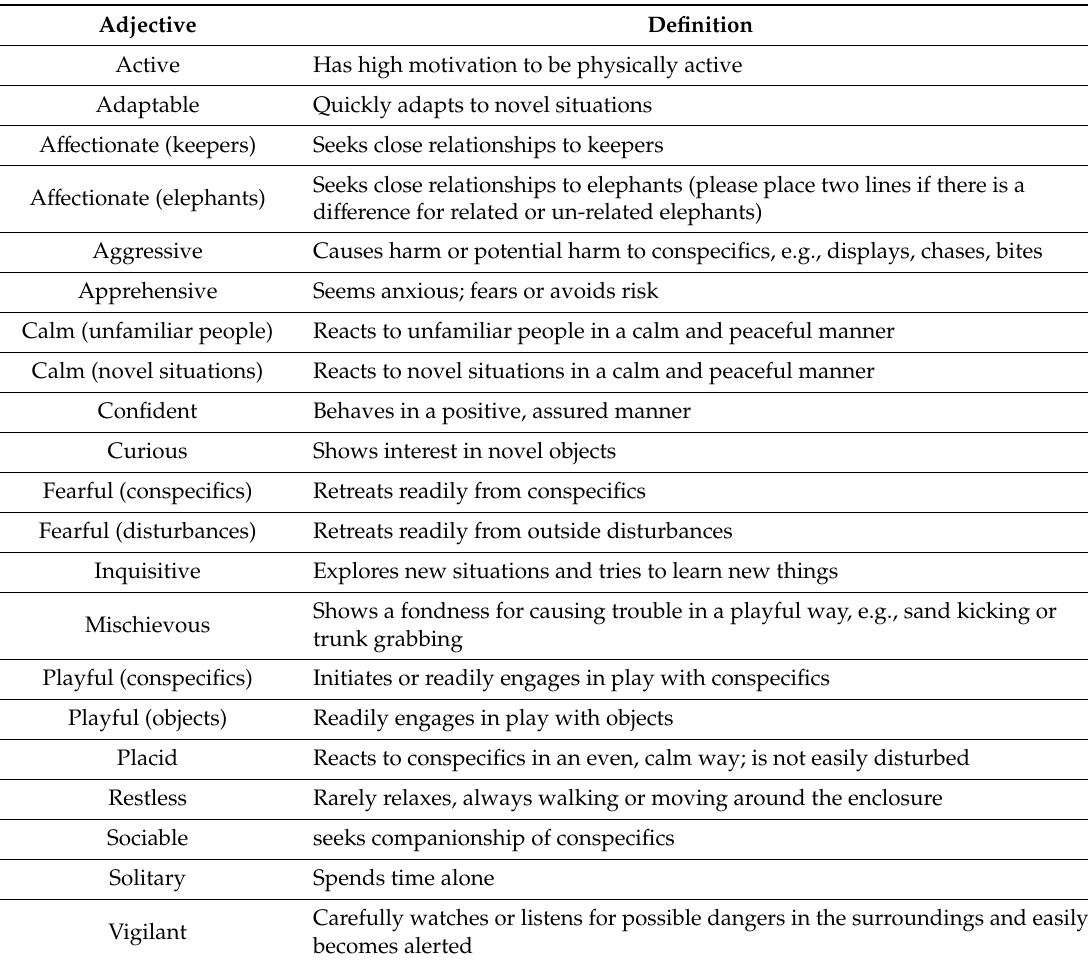
Table 3. Adjective and behavioural definitions included in the elephant personality assessment sent